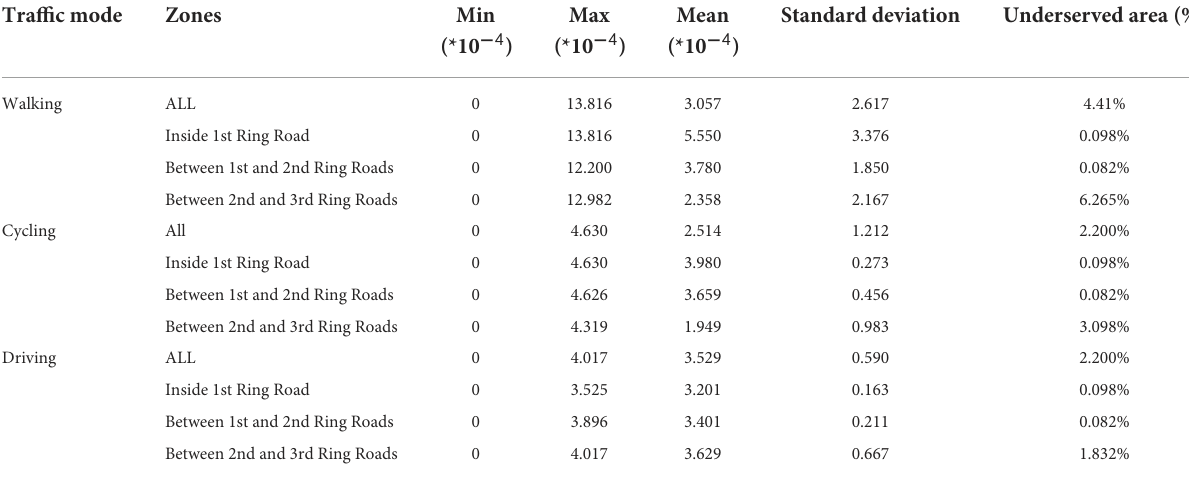
TABLE 2 Statistical analysis of park accessibility in different regions of Chengdu, China. Traffic